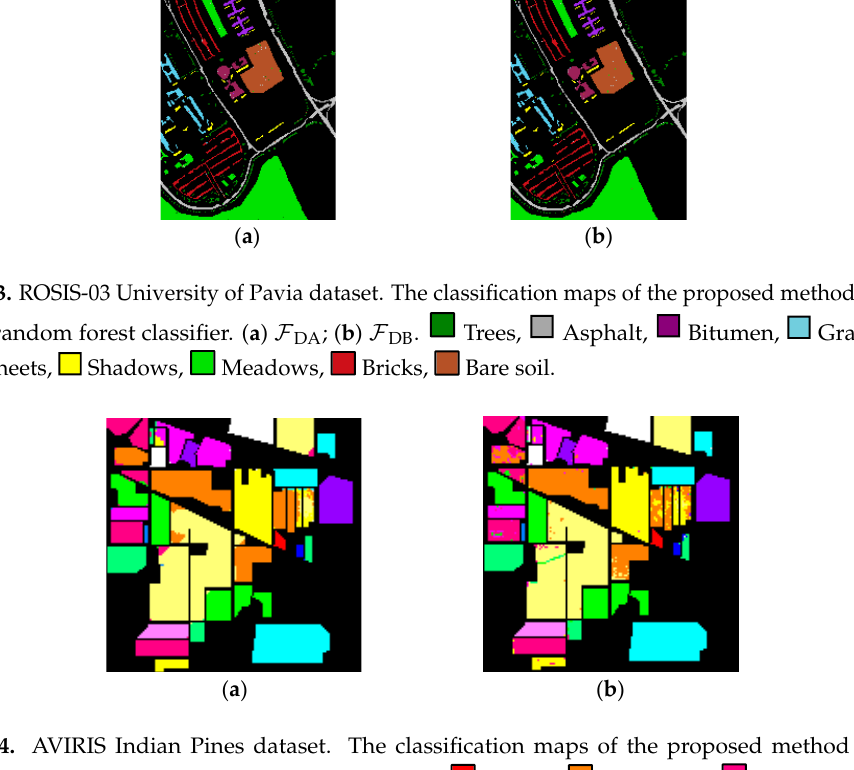
by the random forest classifier, ( a ) F DA ; ( b ) F DB .